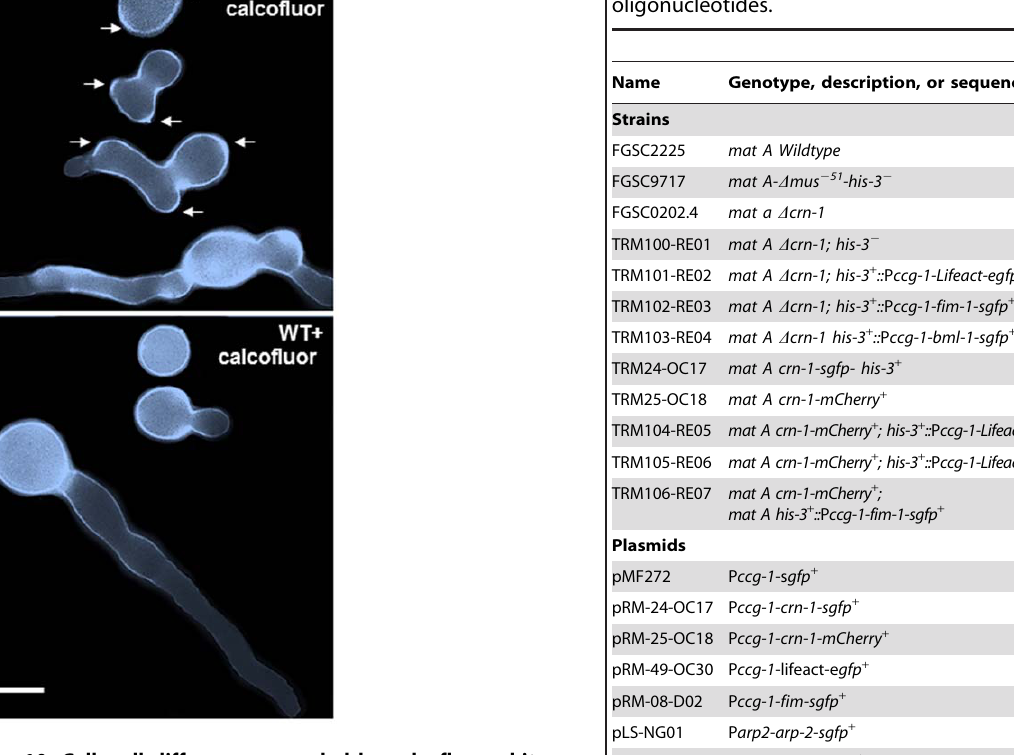
Figure 10. Cell wall differences revealed by calcofluor white. Composite image of cells stained with calcofluor white (0.01%) and arranged to show different developmental stages in (A) the D crn-1 mutant and (B) the WT strain. Arrows point to some of the uneven distribution of cell wall accumulation. Scale bar=5 m m.